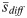
Average modulation performance.The bars represent the mean difference s¯diff between the model score of the action period minus the corresponding resting period, averaged across trials (Eq 11) separated in sessions (S01: A and B; S02: C and D) and task (→ happy: A and C; → sad: B and D). Numbers in parentheses denote the number of trials for the respective participant/task/session combination and the asterisks (*) those combinations with significant modulation performance.